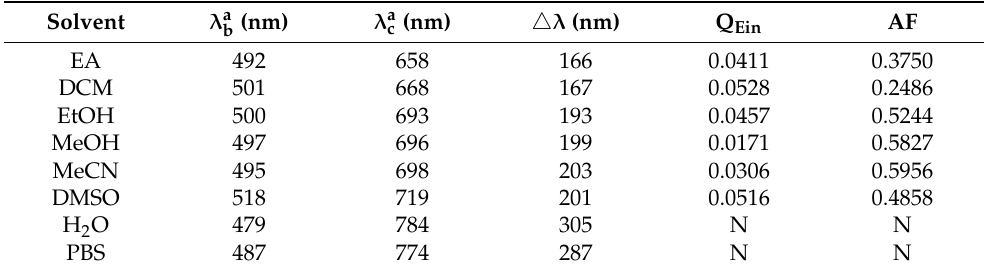
Table 1. M-3 spectrum data.